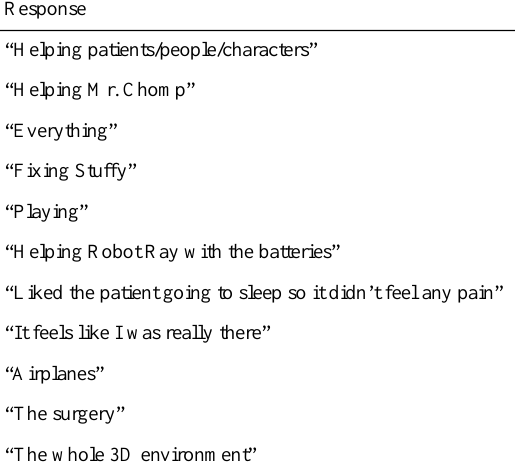
Number of patients